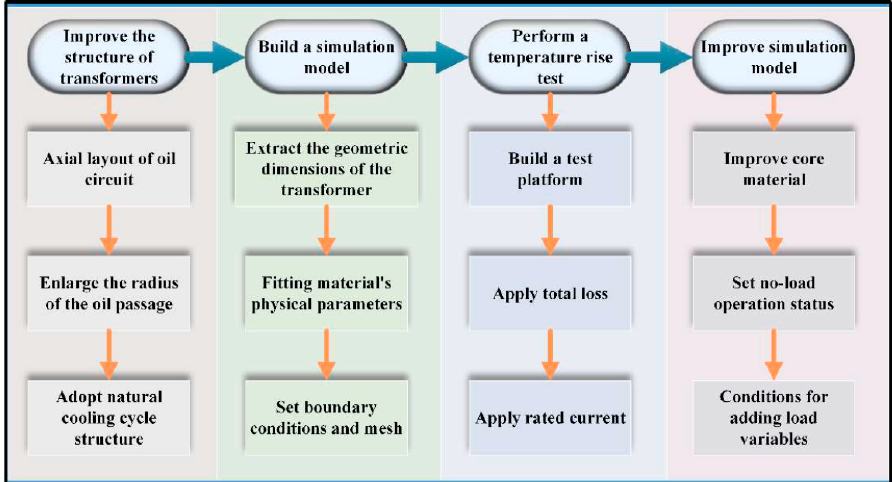
Figure 1. Flow chart of the work of this